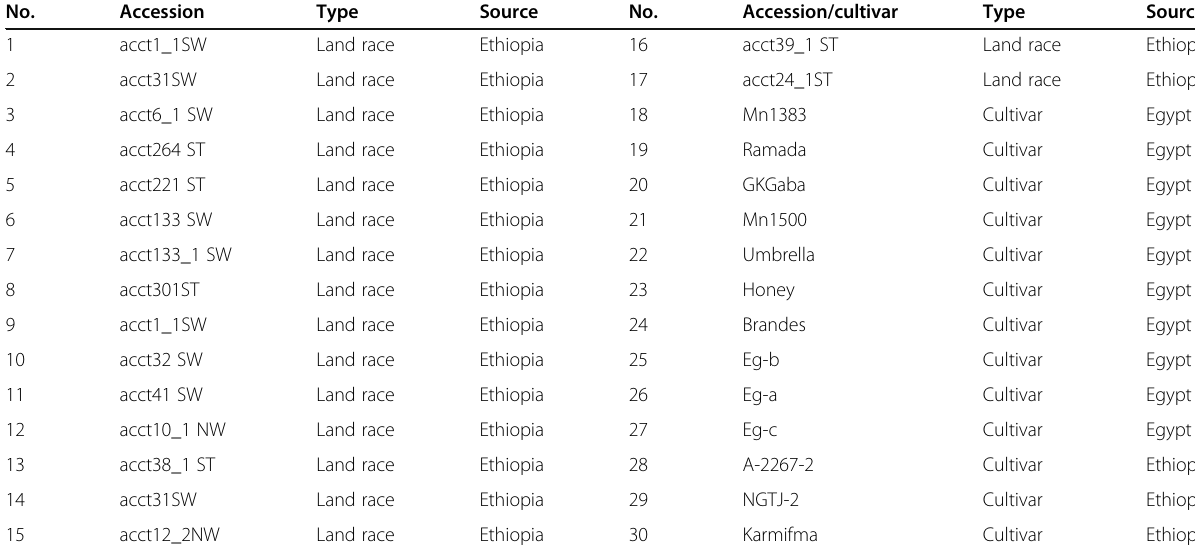
Table 1 List and source of 30 sweet sorghum genotypes used in the study No.